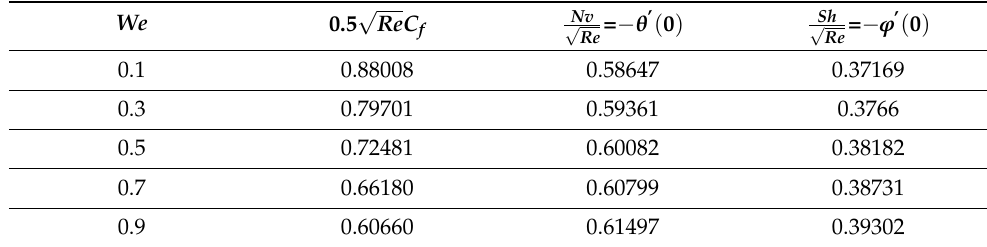
Table 1. Numerical results of local skin-friction, Nusselt and Sherwood numbers for n = 1; Ec = 0.2;